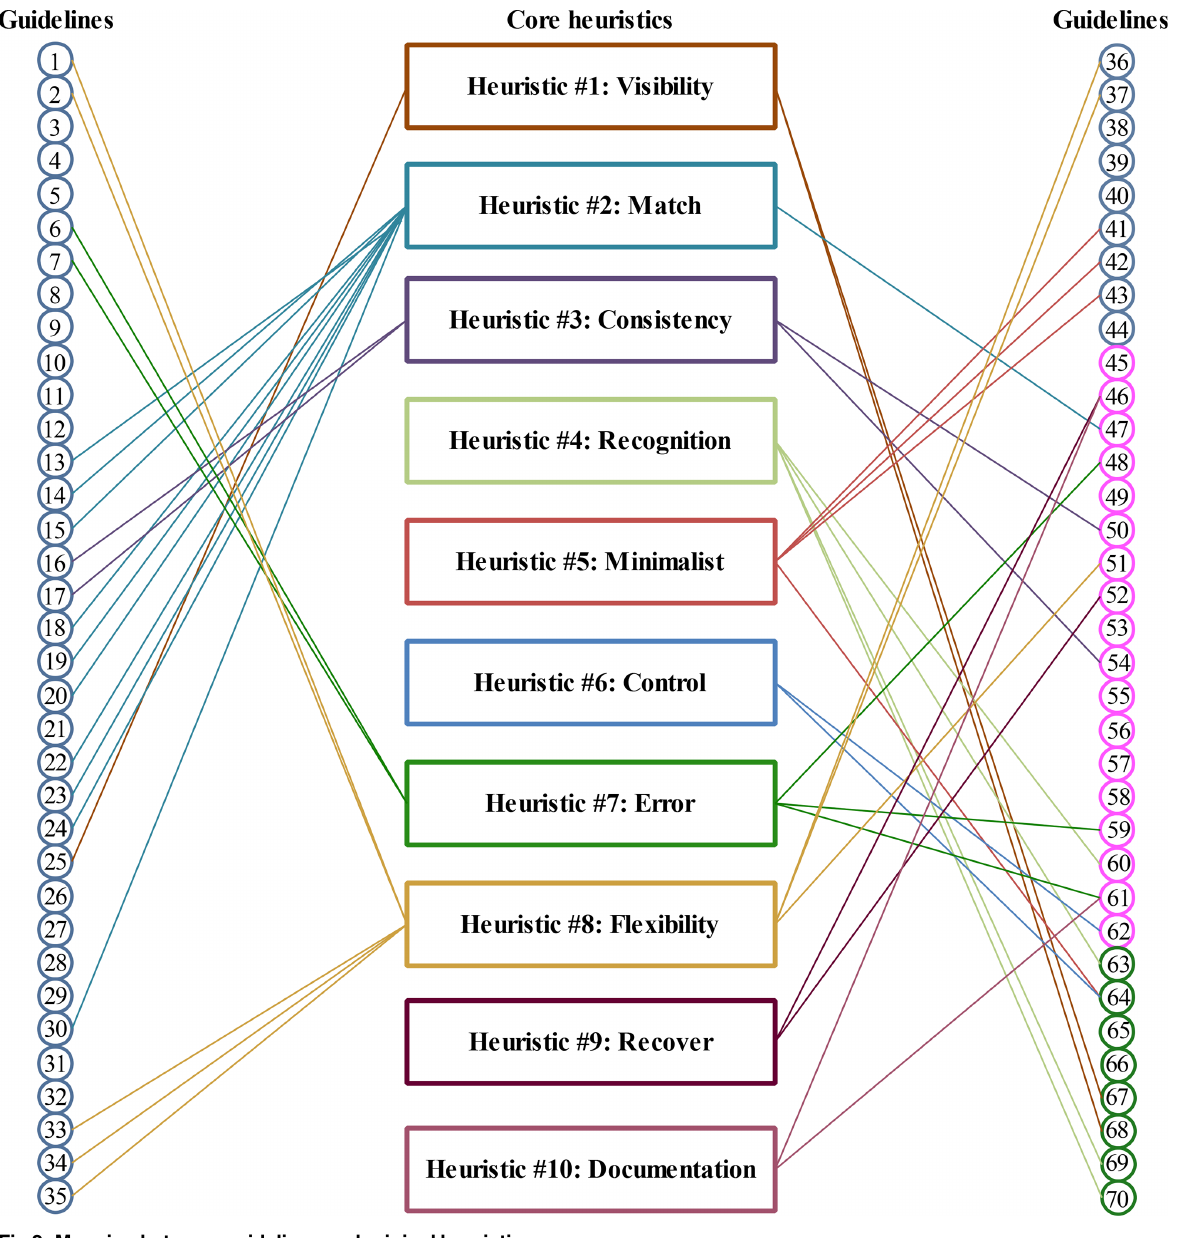
Fig 2. Mapping between guidelines and original